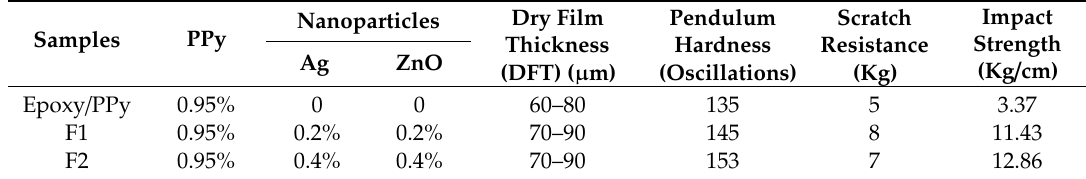
Table 2. Obtained values of dry film thickness, pendulum hardness, scratch resistance, and impact strength for the di ff erent ZnO and Ag-incorporated epoxy PPy coatings.